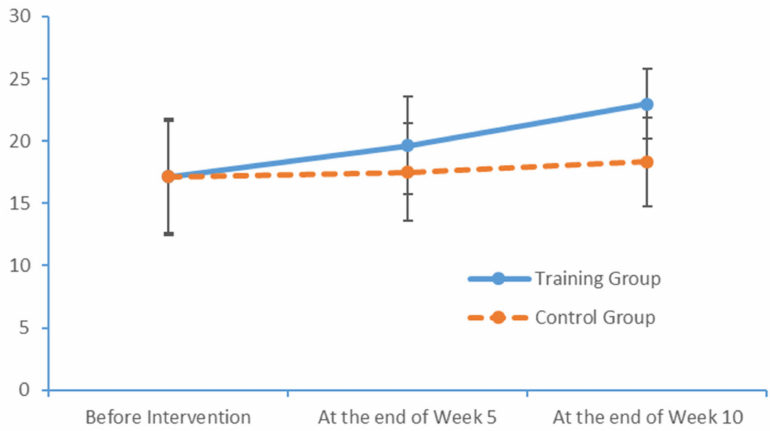
Figure 8. Changes in the MoCA scores of the two groups at each time